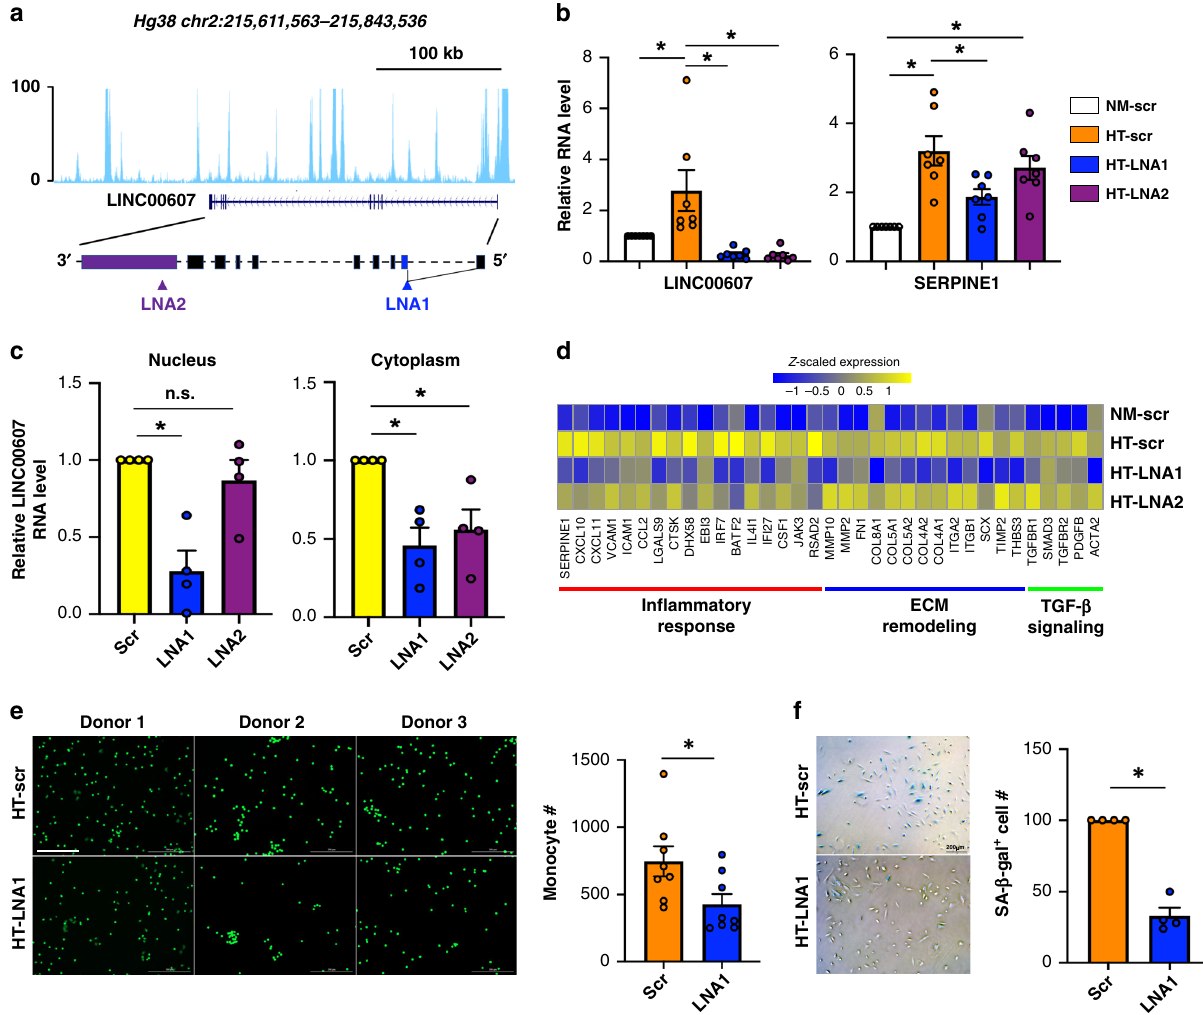
Fig. 4 Inhibition of LINC00607 attenuates SERPINE1 induction and EC dysfunction. a Illustration of LINC00607 genomic locus and gene structure and LNA GapmeRs targeting of LINC00607 RNA. b HUVECs were transfected with scramble (scr) or two LNAs targeting LINC00607. LINC00607 RNA and SERPINE1 mRNA levels were quanti fi ed. Data represent mean ± SEM from seven independent experiments. c qPCR of LINC00607 in subcellular fractionations of HUVECs transfected with scr, LNA1, or LNA2. Data represent mean ± SEM from four independent experiments. d RNA-seq was performed with cells transfected as in b in biological replicates. Heatmap is plotted based on z -scaled log-transformed gene expression levels. e , f ECs transfected with scr or LNA1 and then treated by H + T were used in e monocyte adhesion assay and in f SA- β -gal assay. In e , the number of attached monocytes to ECs were quanti fi ed. Data represent mean ± SEM from eight independent experiments performed with peripheral blood-derived monocytes from four individual donors. Representative images show the attachment of fl uorescently labeled peripheral blood-derived monocytes to ECs for experiments performed with monocytes from three different donors. In f , ECs with positive β -gal staining were quanti fi ed. The positively stained cell number in scr control was set to 100 (%). f Data represent mean ± SEM from four independent experiments respectively. Scale bar = 200 μ m. * denotes p = 0.0289, 0.0013, 0.001, 0.0001, 0.0025, and 0.024 from left to right (in b ) and p = 0.0023, 0.0079, and 0.0249 from left to right (in c ) between indicated groups based on ANOVA followed by Bonferroni post hoc test (in b and c ); p = 0.0039 (in e ) and 0.0014 (in f ), as compared to scr group based on two-tailed paired t test (in e and f ). Source data are provided as a Source data fi